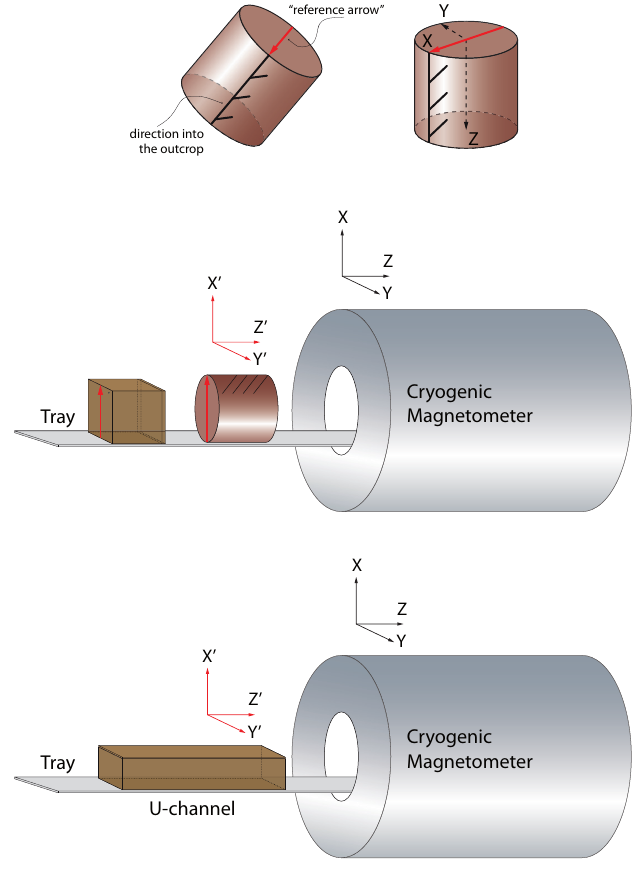
Figure 3. The convention for the specimen coordinate system. See text for